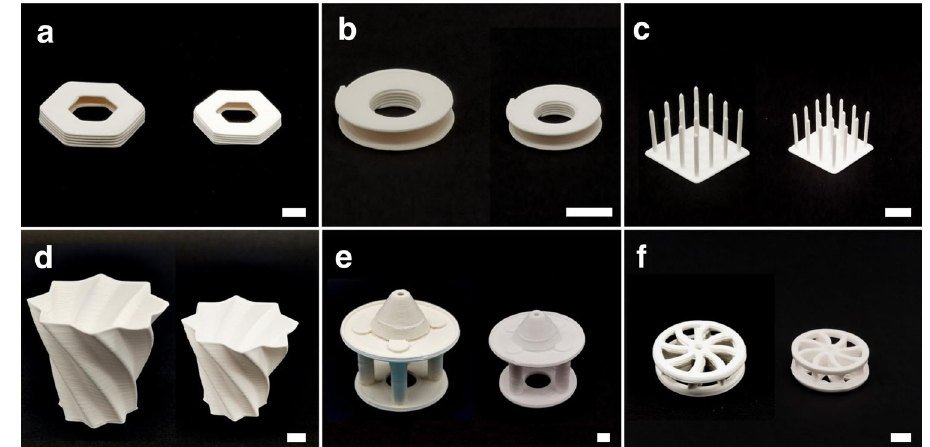
Fig. 6 | The structuralstabilityand fi delity ofthe printed partswere evaluated by NIR-DIW. Different architectures of a overhanging hexagonal prisms, b pulley were printed with 0.41mm nozzle. Different architectures of c freestanding pillar